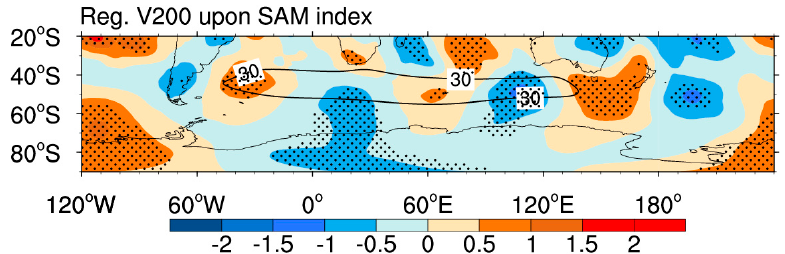
Figure 11. As in Figure 2a, but for anomalies of V200 associated with the SAM mode, which is represented by the EOF 1 mode of extratropical geopotential height at 200 hPa south of 20° S in austral summer.